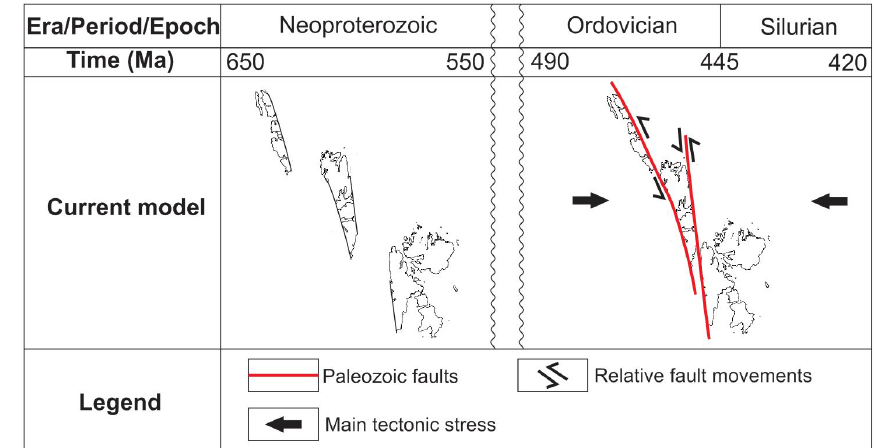
Figure 2. Paleogeographic reconstruction of the Svalbard Archipelago in the latest Neoproterozoic during the Timanian Orogeny and in the early to mid-Paleozoic during the Caledonian Orogeny according to previous models (e.g., Harland, 1969; Labrousse et al.,